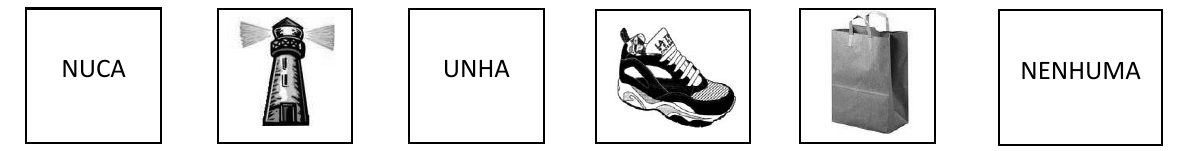
Figura 2 . Item de reconhecimento do teste